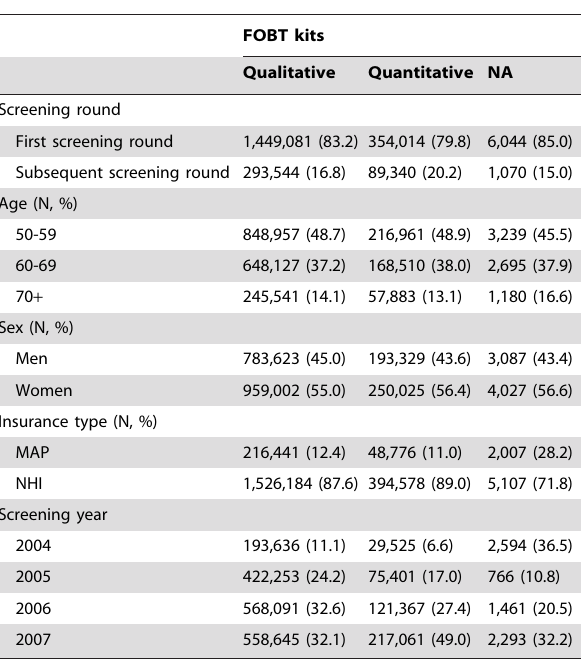
Table 1. Characteristics of the screening participants (by each screening for participants with multiple screenings) of the National Cancer Screening Program,